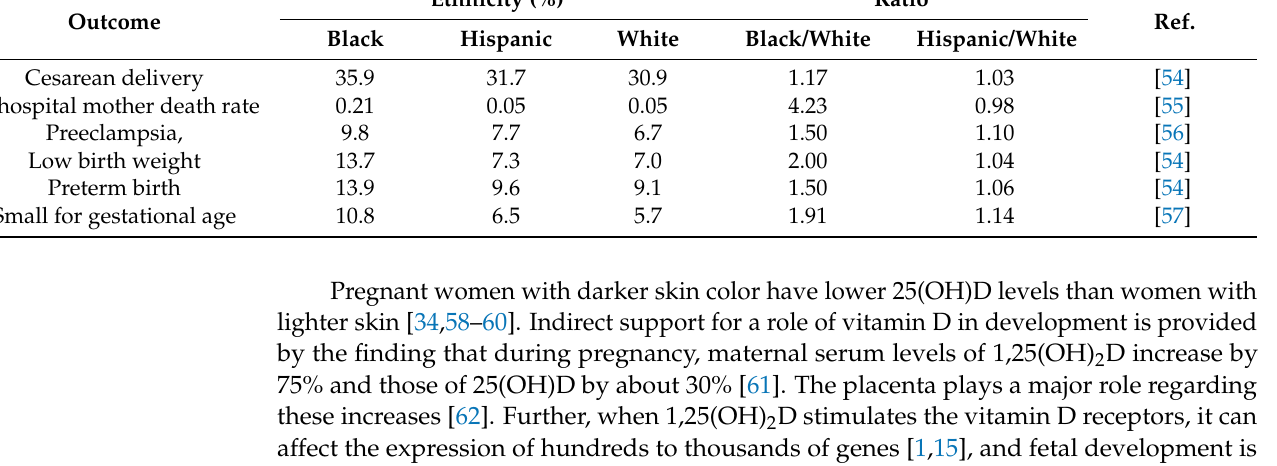
Ethnicity (%) Ratio